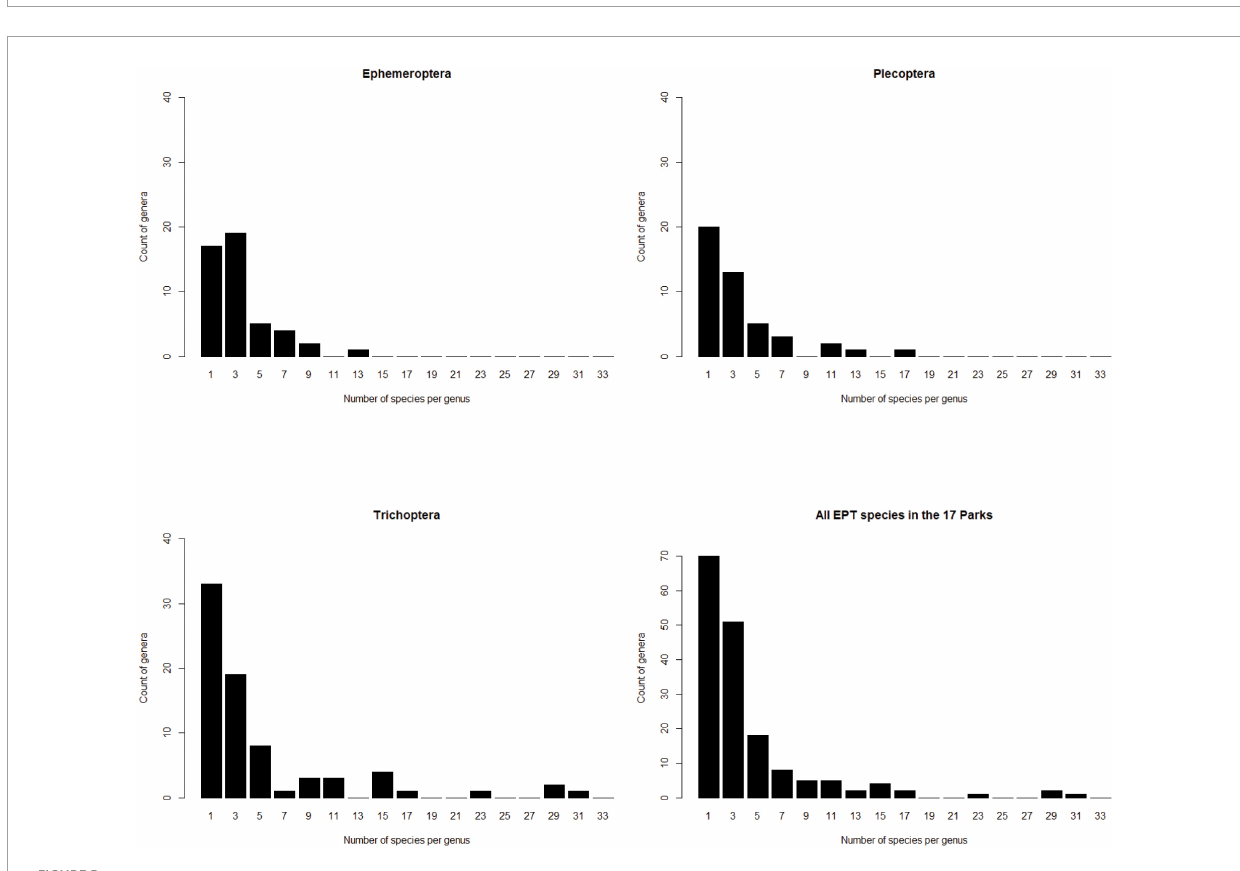
coincidence that there are general similarities in the ecological and evolutionary forces challenging the survival, dispersal and reproduction of organisms in aquatic systems across the planet